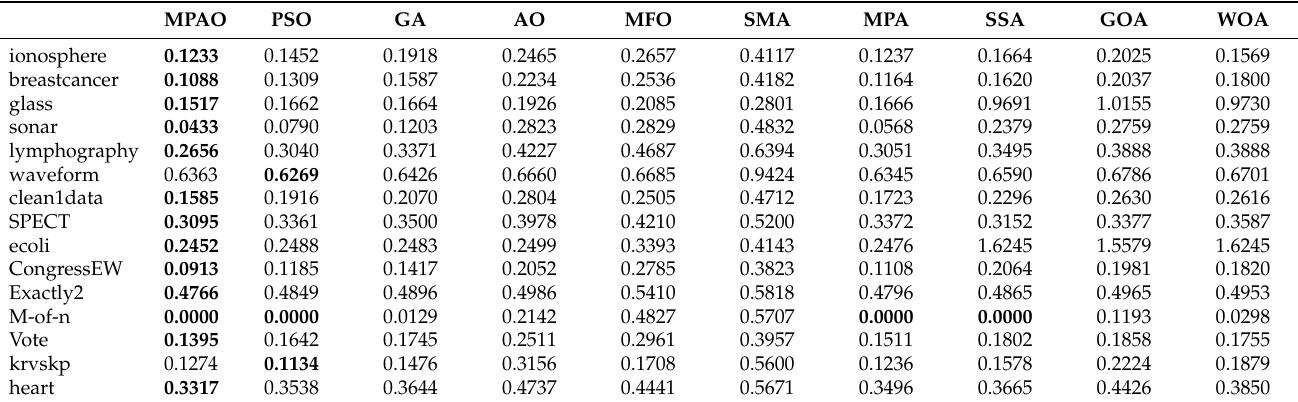
Table 7. Results of the average of the fitness value.